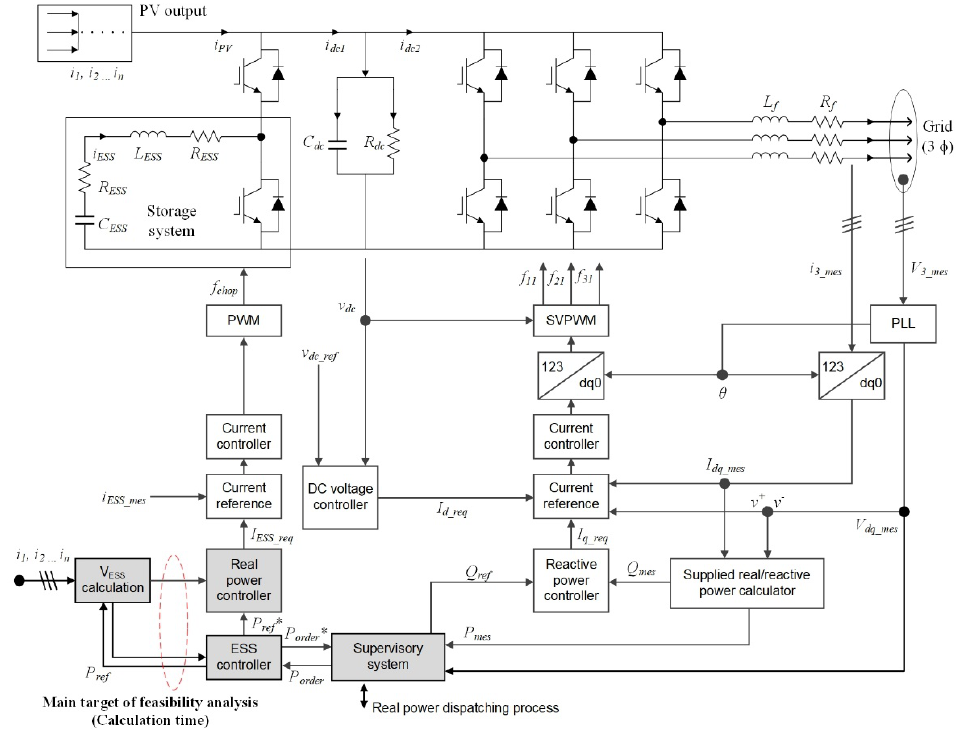
Figure 1. Typical structure of a photovoltaic (PV)-energy storage system (ESS) power conversion system. PLL, phasor locked loop.